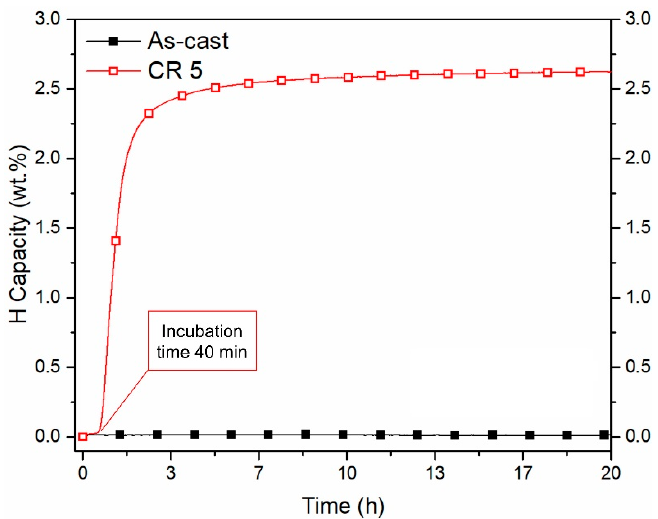
Figure 3. Activation curve of 1.2Ti–0.8Fe with and without cold rolling.